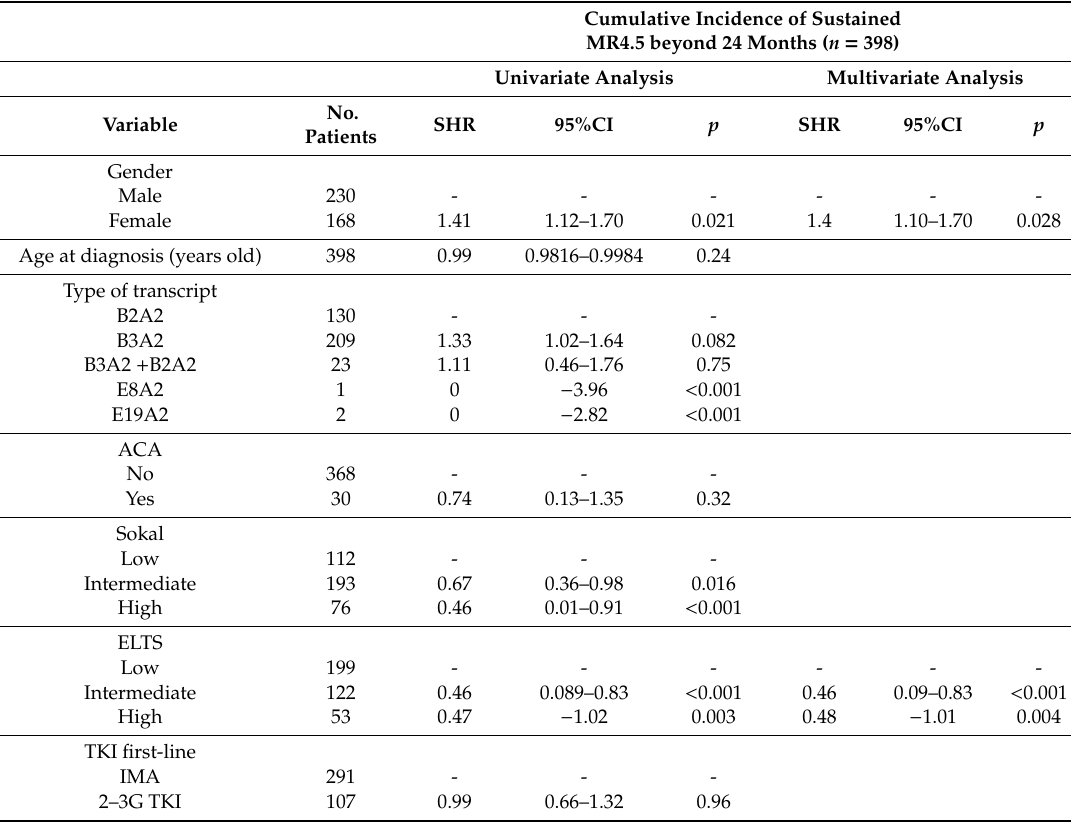
Table 2. Predictive factors of sustained MR4.5 for at least 24 months by univariate and multivariate Gray’s test and Fine and Gray Model